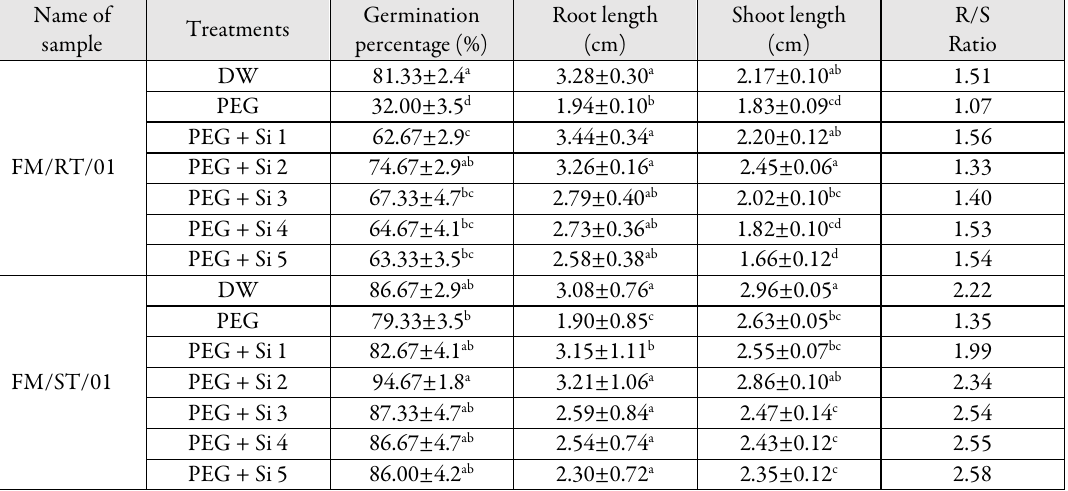
Table 1. Effect of Si on germination percentage, root length and shoot length of local finger millet